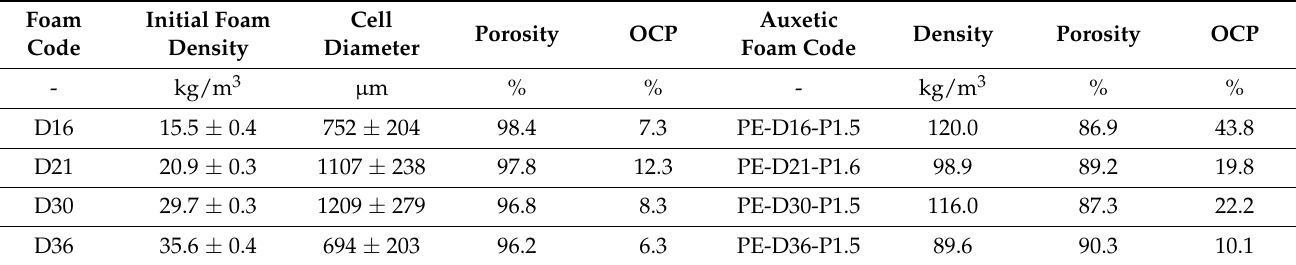
Table 1. Properties of the initial LDPE and auxetic